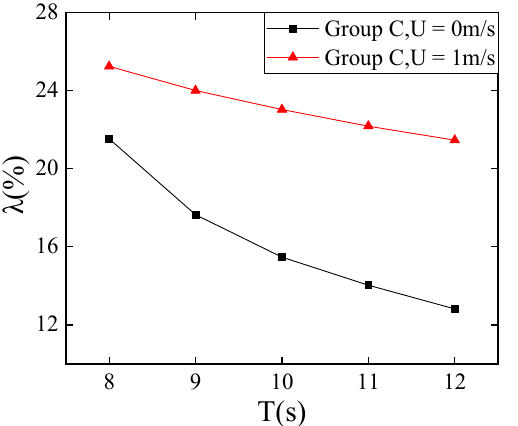
Figure 11. Surge suppression efficiency of the Serbuoys-TLP under different wave periods.